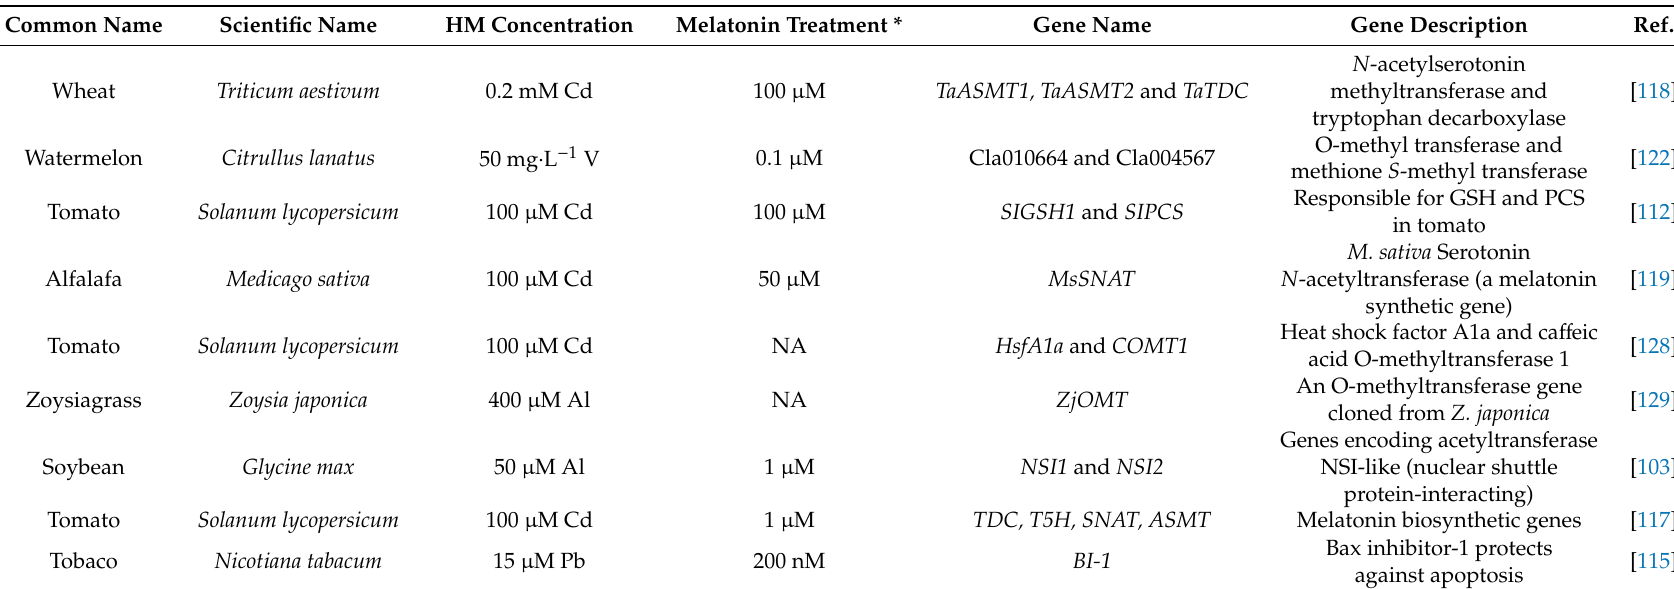
Table 4. Melatonin-upregulated genes under heavy metal